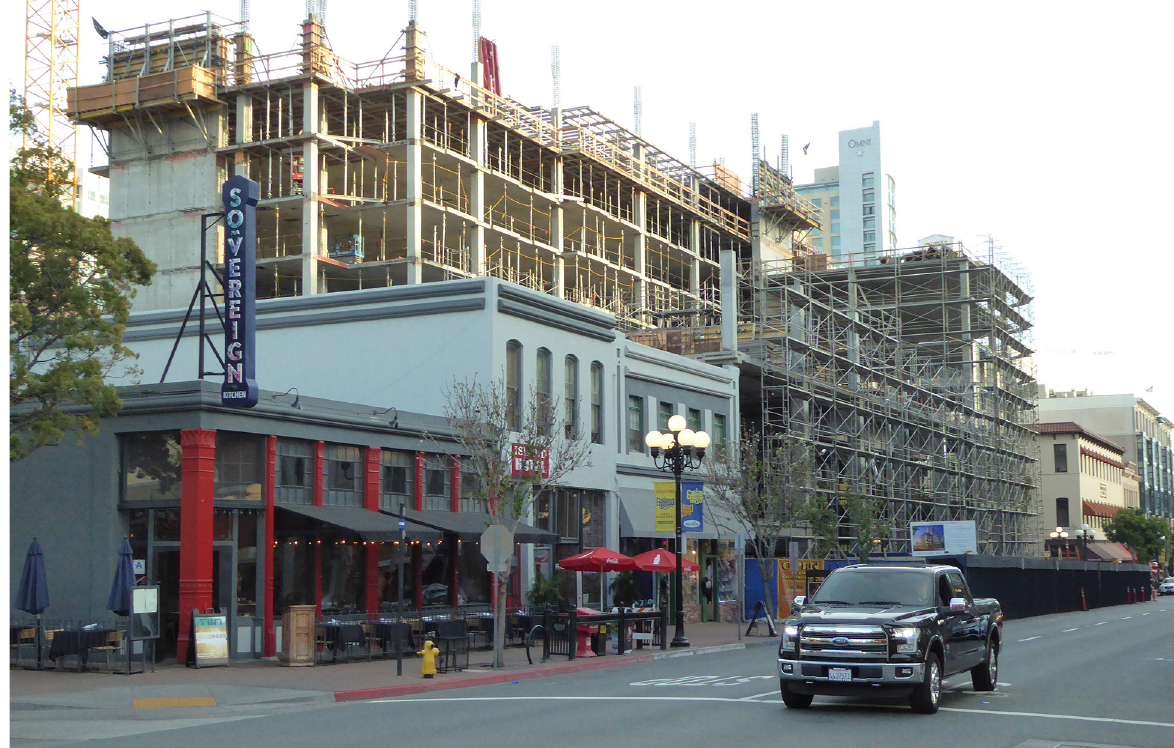
Fig. 8. Changing patterns of construction and use in Golden Hill. Photo by Olaf Kühne